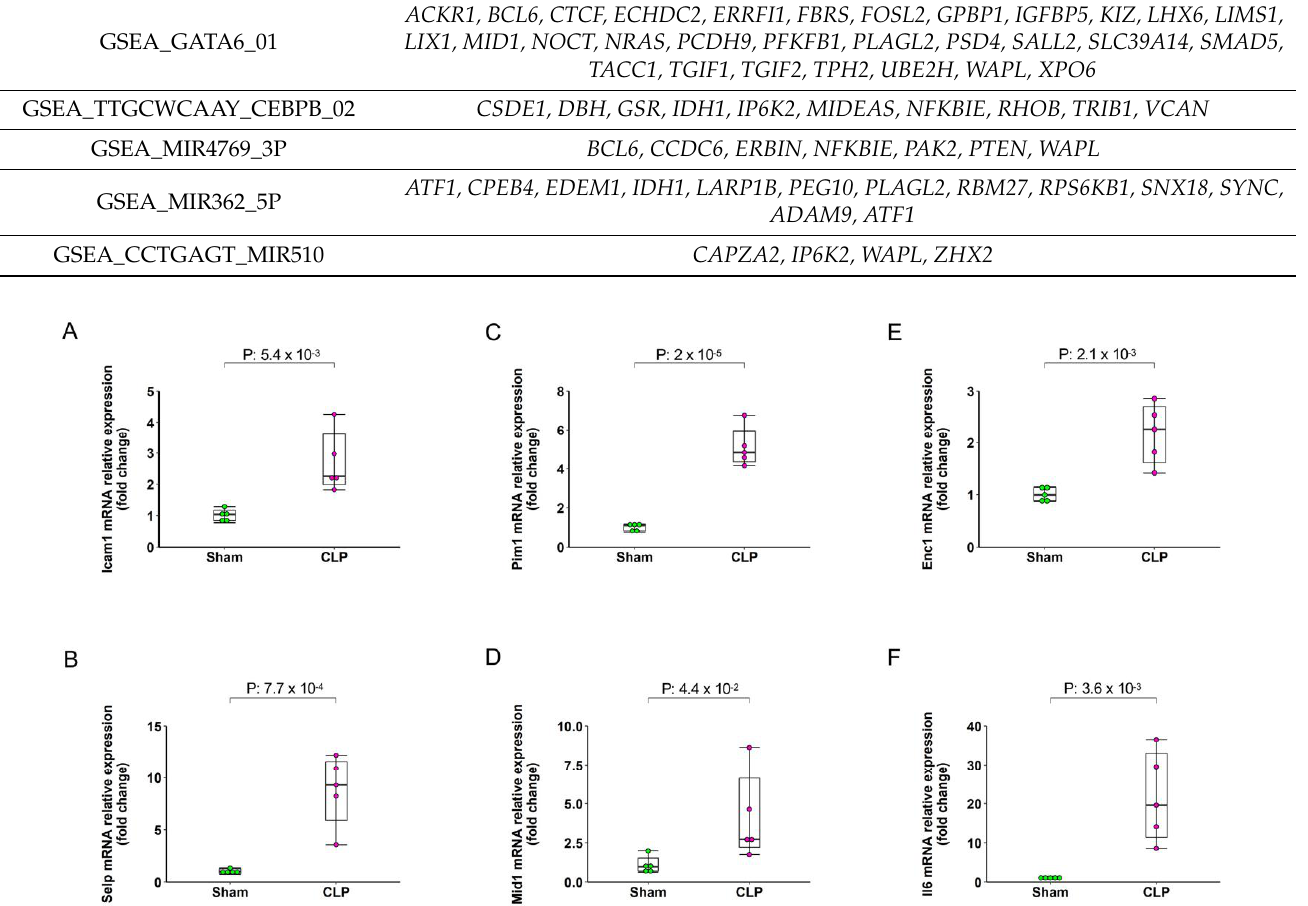
Figure 7. Validation of selected RNA-seq data by qRT-PCR. Samples were collected 4 h after induction of abdominal sepsis. Relative expressions of ( A ) Icam1, ( B ) Selp, ( C ) Pim1, ( D ) Mid1, ( E ) Enc1 and ( F ) Il6 mRNAs were quantified using qRT-PCR where GAPDH was used as a housekeeping gene for mRNA and expressions were determined using 2 –ΔΔCT method. Box plots represent the median (25 – 75 percentile) and the whiskers extend from the minimum to the maximum levels and dots represent sample values and n = 5.